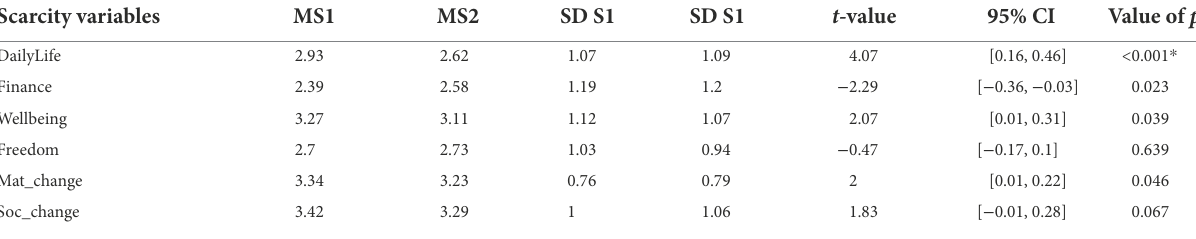
TABLE 2 Comparison between perceived scarcity measures in S1 ( N = 600) and S2 ( N = 300). Scarcity